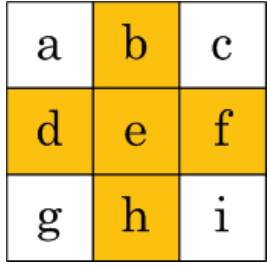
Figure 12. A sample 3 × 3 integral image block for the proposed method. The shaded region shows the integral image values that need to be